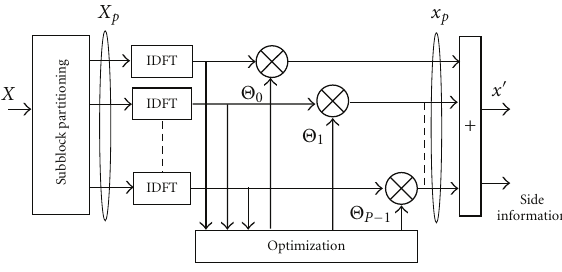
Figure 4: Block diagram for the partial transmit sequence PAPR reduction